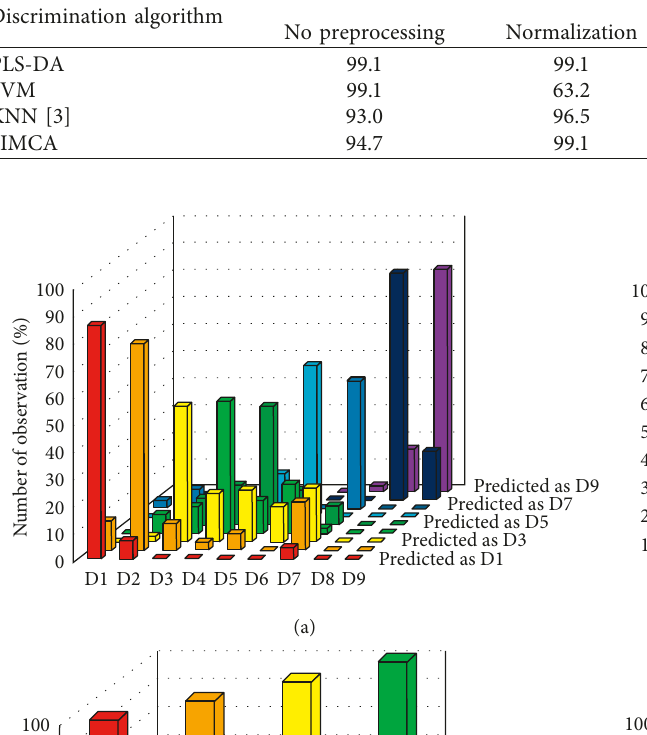
Table 2: The results of the discrimination success rate at the first level of expert system. Discrimination